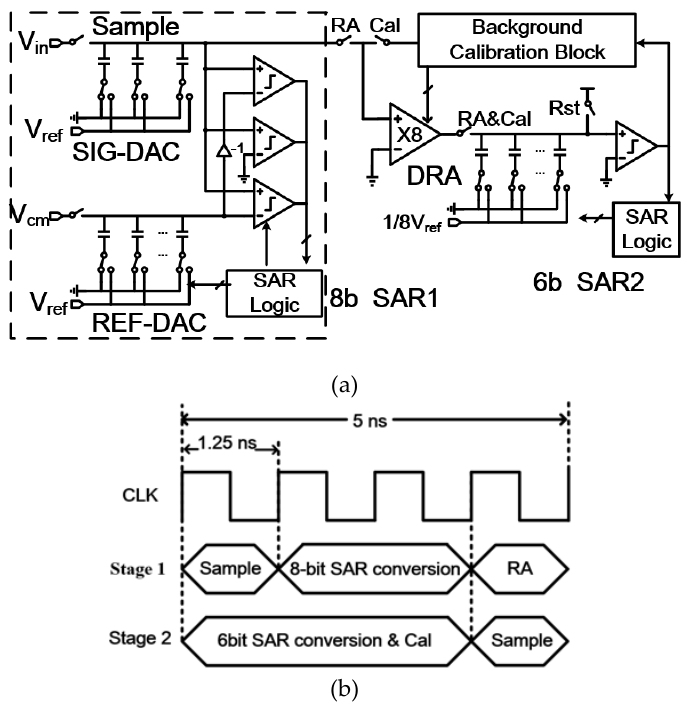
Figure 1. ( a ) Block diagram of the proposed ADC; ( b ) timing diagram of the proposed ADC.